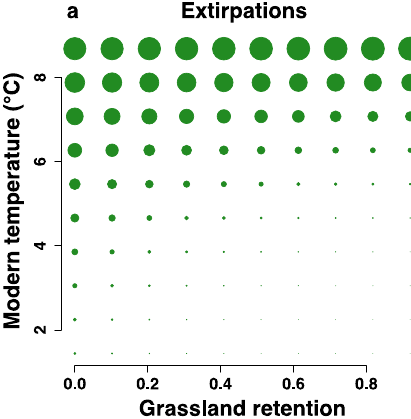
Fig. 4 | Interactive effects of land use and climate change on plant community turnover. Panels illustrate effect of land-use – climate interactions on a extirpations and b colonisations of all species within a grid cell, based on binomial generalised linear mixed effects models ( n =1231 grid cells). The size of the points indicates the relative level of extirpation or colonisation in a grid cell over time, according to the